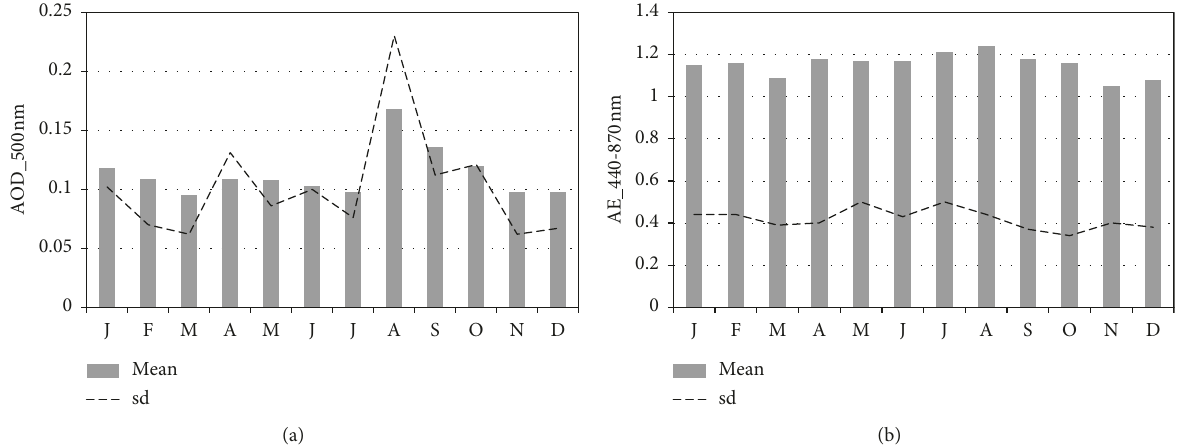
Figure 2: Monthly means and standard deviations of AOD500nm (a) and ˚Angstr¨om exponent (b) at CEILAP-BA (climatological values for the period